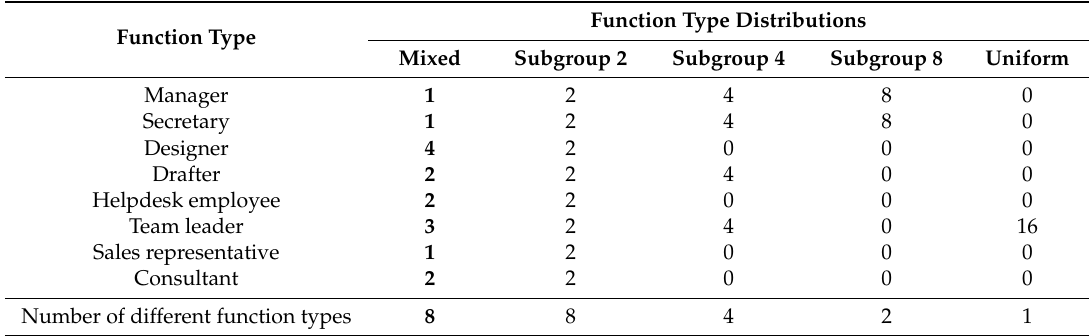
Table 4. Function type distributions for the simulation case (in bold) and the test